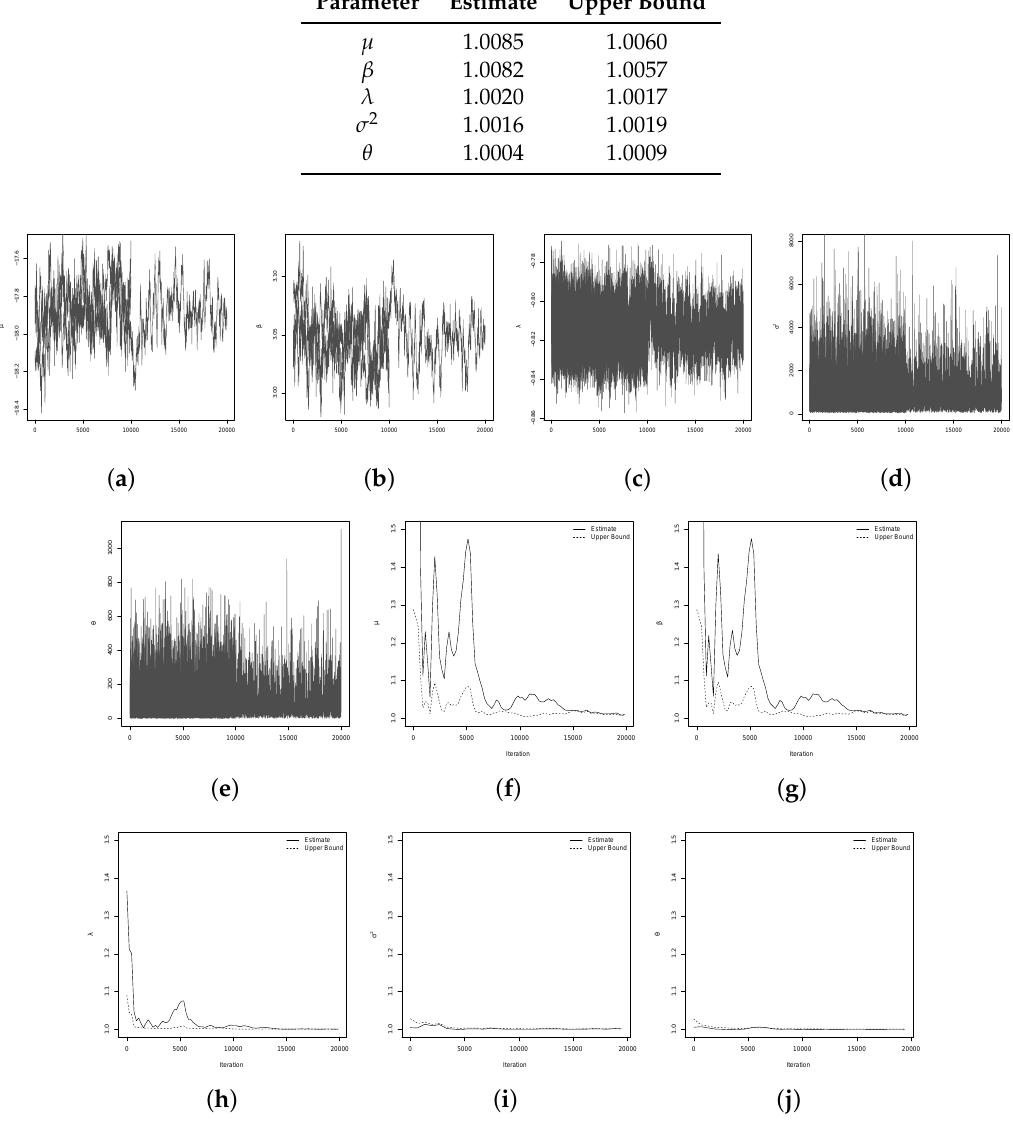
Figure 3. Traceplots and convergence plots, respectively, for: ( a , f ): µ ; ( b , g ): β ; ( c , h ): λ ; ( d , i ): σ 2 and; ( e , j ): θ . Also, the marginal posterior densities for µ , β and λ , respectively, can be analyzed by the Figure 4a–e. After estimate and analyze the convergence of the model, Figure 5a,b show us, respectively, the hazard estimate curve, with the ˆ T max and the T max 95% confidence interval; the survival curves estimated vs empirical and the histograma which are possible to see how well it fits a set of